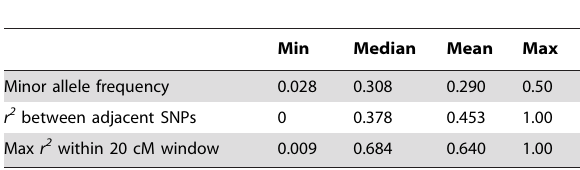
Table 1. Properties of SNPs scored for the Barley